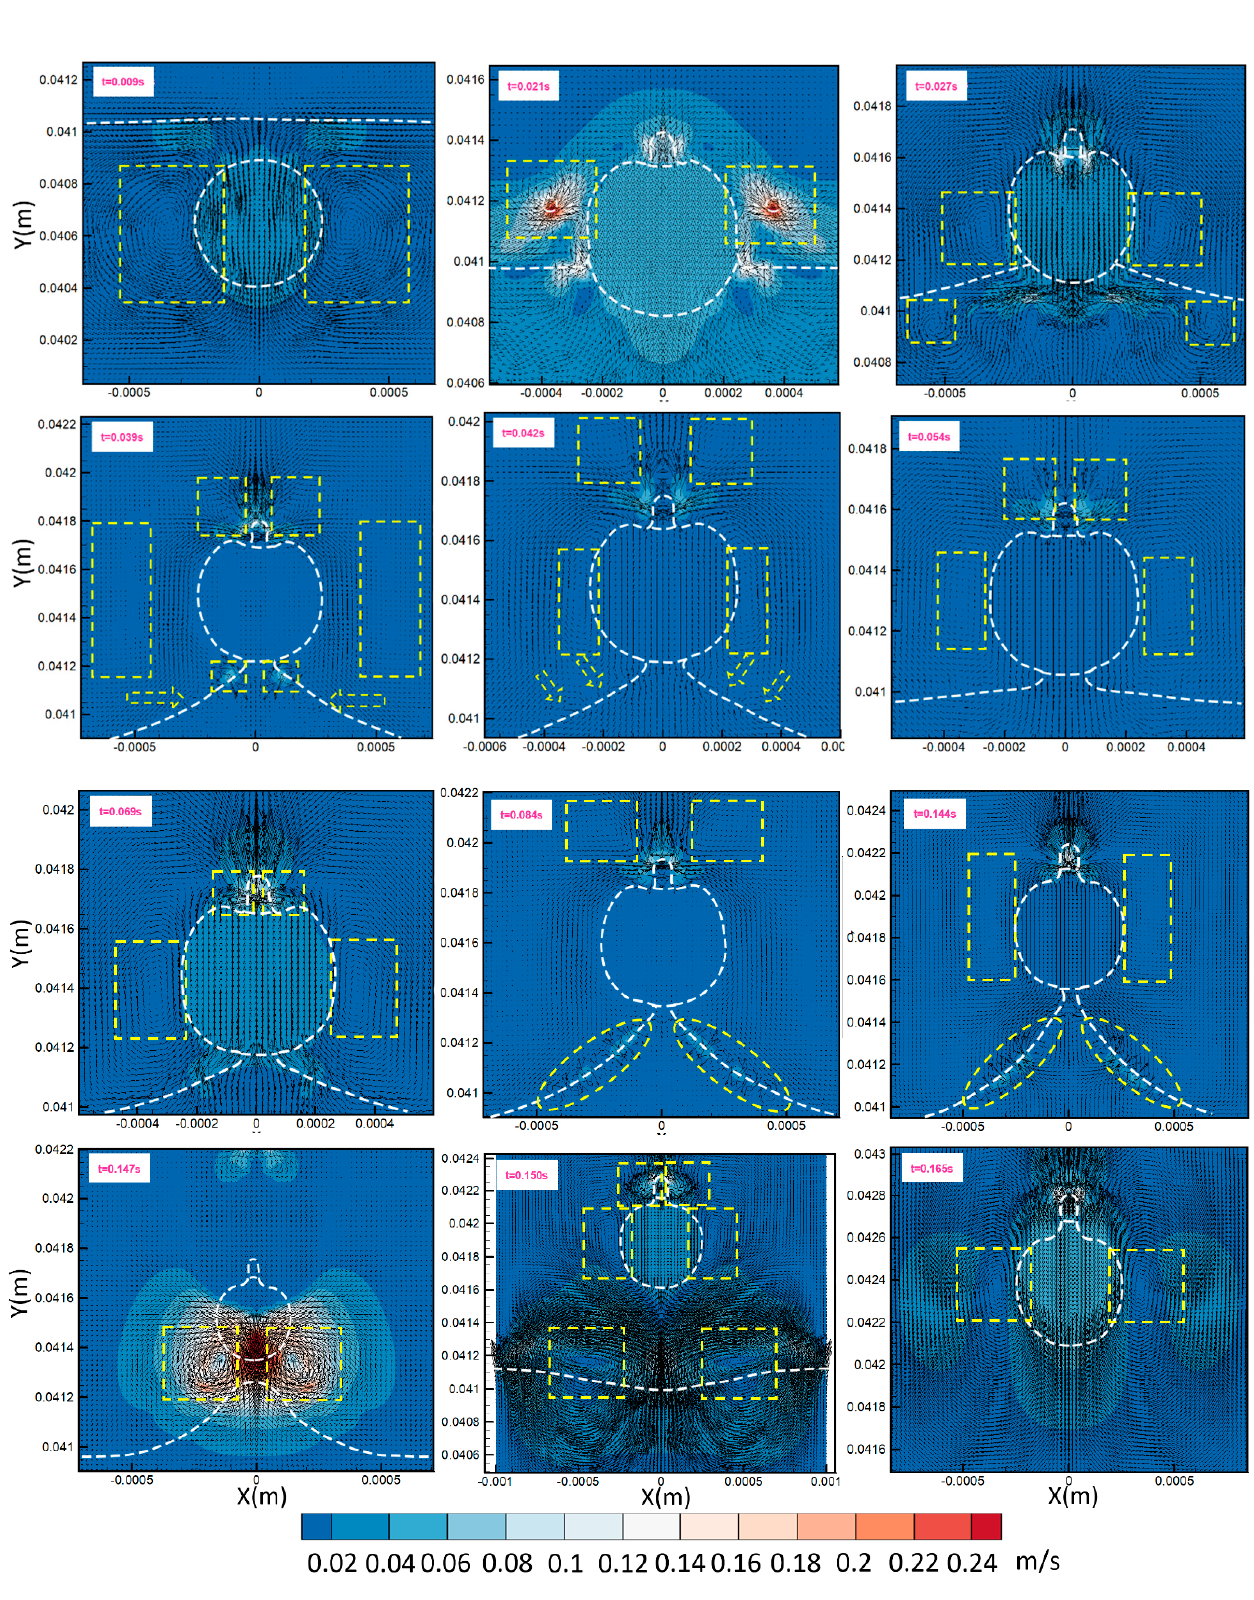
Figure 5. Fluid flow velocity vector (arrows) and velocity magnitude (colored contour) when a droplet crosses a fluidic barrier. The time of each image is shown in the top-left by a pink text. The yellow and white dashed lines indicate the vortices and liquid interface,